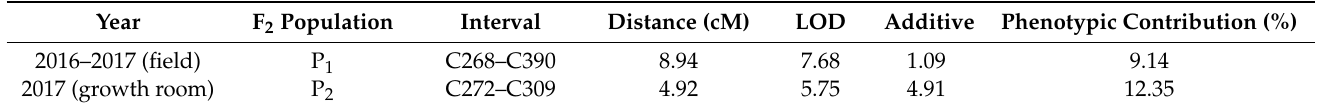
Figure 8. Genetic maps and QTL regions were created using the heading date and genotype data from two (CASL7BS × CS) F 2 populations. ( A ): Chromosome 7B indicating the chromosome structure in CASL7BS and 7BL. The region highlighted with yellow is the common TTD segment shared by CASL7BS and CASL7BL. ( B ): The physical map. The region highlighted with red indicates the location of the HD-related QTL. ( C , D ): Genetic map constructed by P 1 and P 2 mapping populations. The regions highlighted with black indicate the locations of the HD-related QTL. Table 3. QTL detection of heading date by using (CASL7BS × CS) F2